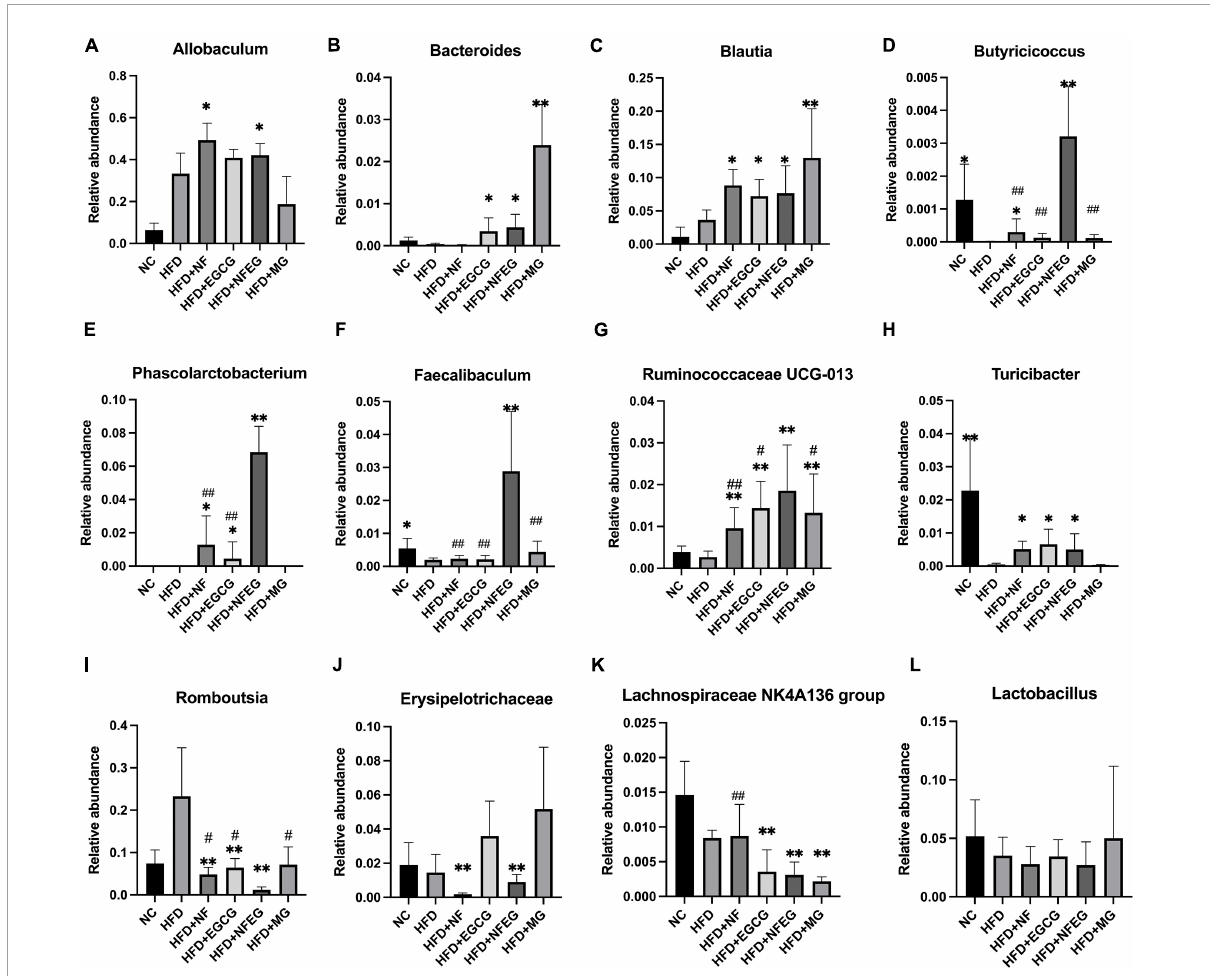
FIGURE7 NFEG-microgel changed the relative abundance of gut microbiota in HFD-fed rats. Relative abundance of Allobaculum (A) , Blautia (B) , Bacteroides (C) , Butyricicoccus (D) , Phascolarctobacterium (E) , Faecalibaculum (F) , Ruminococcaceae UCG-013 (G) , Turicibacter (H) , Romboutsia (I) , Erysipelotrichaceae (J) , Lachnospiraceae_NK4A136_group (K) , and Lactobacillus (L) . (* P < 0.05) and (** P < 0.01) vs. HFD group; ( # P < 0.05) and ( ## P < 0.01) vs. HFD + NFEG